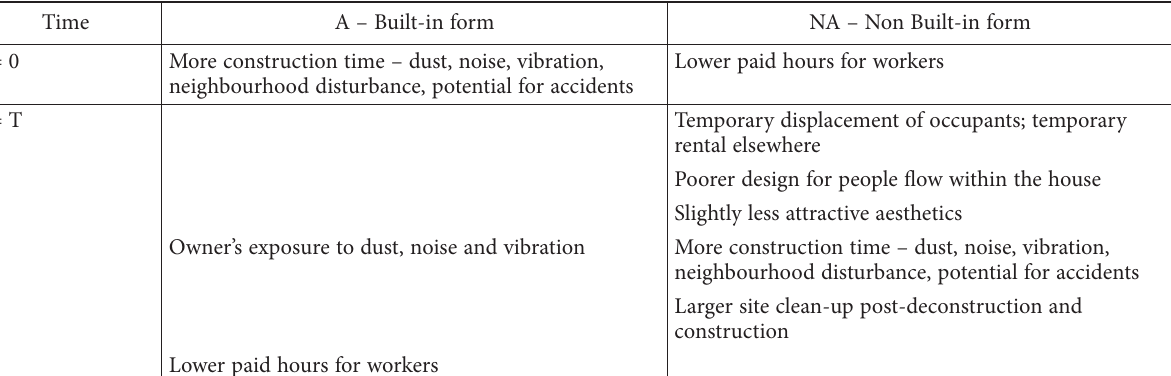
Figure 4. Unit processes and inventory flows for the SLCA Table 4. Comparison of social issues